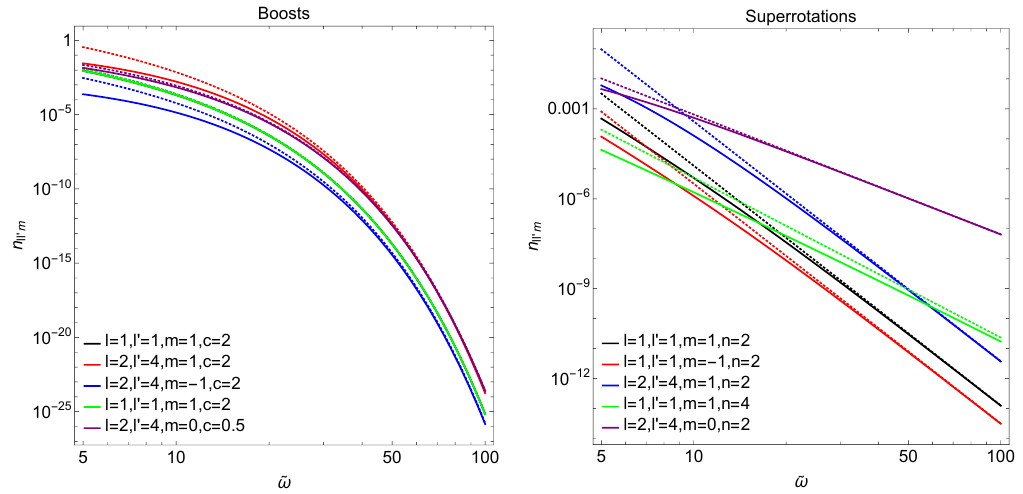
Figure 3 . The matrix elements n ll 0 m for boosts (left) and superrotations (right) for di(cid:11)erent choices of l; l 0 ; m as a function of ~ ! = 2 (cid:25)!=(cid:20) . Solid lines are the numerical integrals and dashed lines are the analytical approximations using, for boosts, the leading terms in eqs. (5.47) and (5.48), and for superrotations, eq.